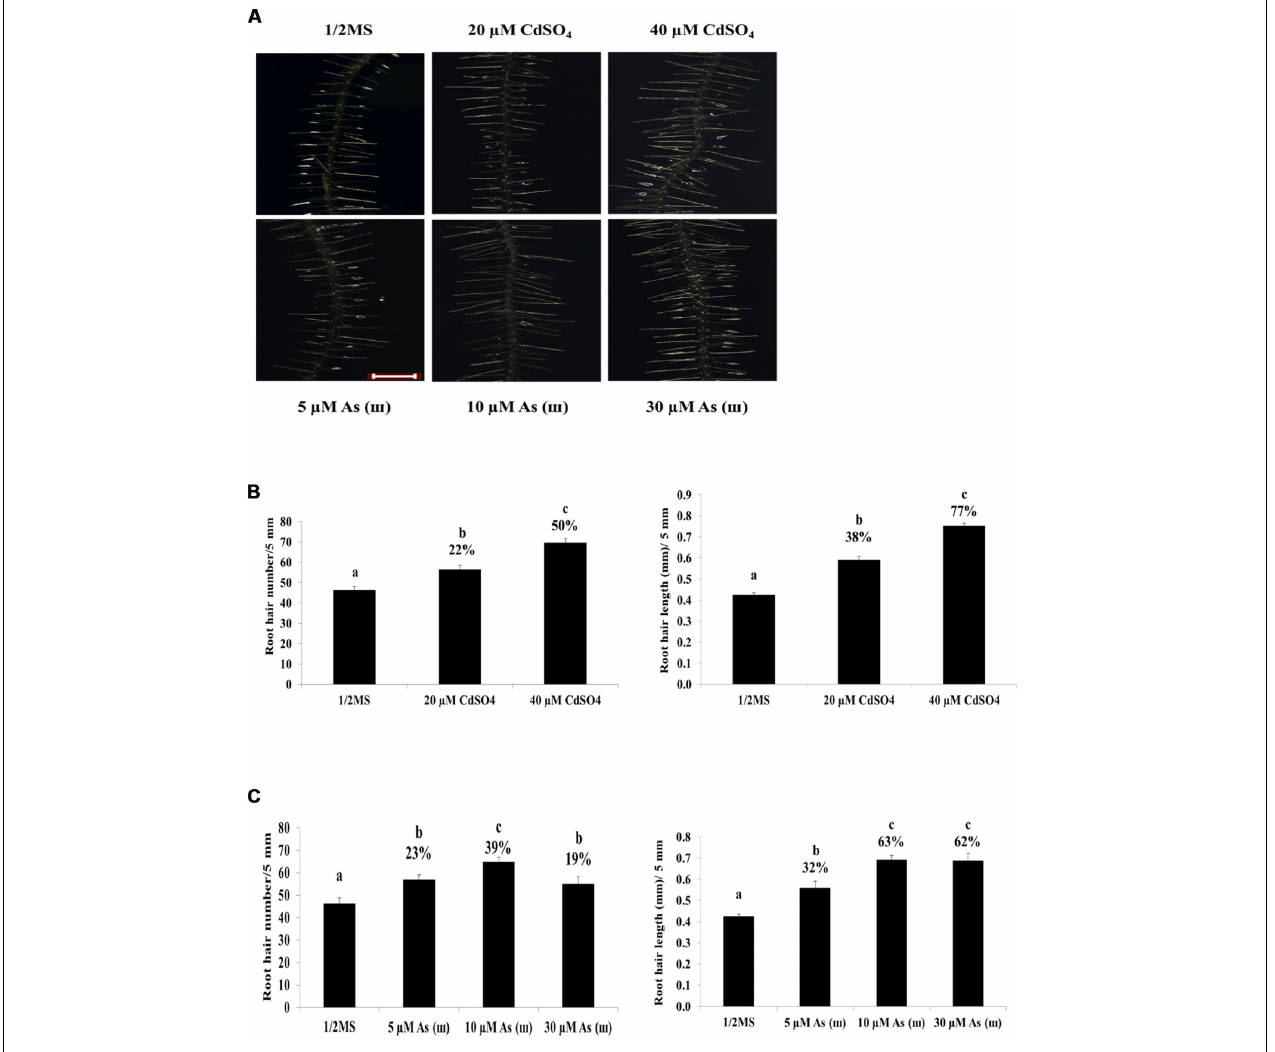
FIGURE 2 | Effect of Cd and As(III) on the length and density of root hairs in Arabidopsis . (A) Root hair morphology of Arabidopsis Col -0 seedlings germinated and grown for a week on 1/2 MS agar media treated with no metal, 20, 40 µ M CdSO 4 , and 5, 10, 30 µ M As(III). Roots were observed at 40 × magnification; scale bars = 0.2 mm. Photographs show plants representative of the 10 plants examined in each experiment. (B) Density and length of root hair treated with Cd shown in (A) . Root hair density was expressed as the number counted in a 5 mm section from the starting point of differentiation zone under a microscope. Root hair length was measured in a 5 mm section of differentiation zone. Root hairs were photographed with Leica Stereoscopic microscope (MZ10F, Germany), and their length was quantified using Image J software as described in Materials and methods. Values are average ( ± SE) of three independent experiments, each involving 10 seedlings. (C) Density and length of root hairs treated with As(III) shown in (A) . Root hair density and length were measured as in (B) . Different letters in each column indicate a significant difference according to Tukey’s multiple comparison test ( p ≤